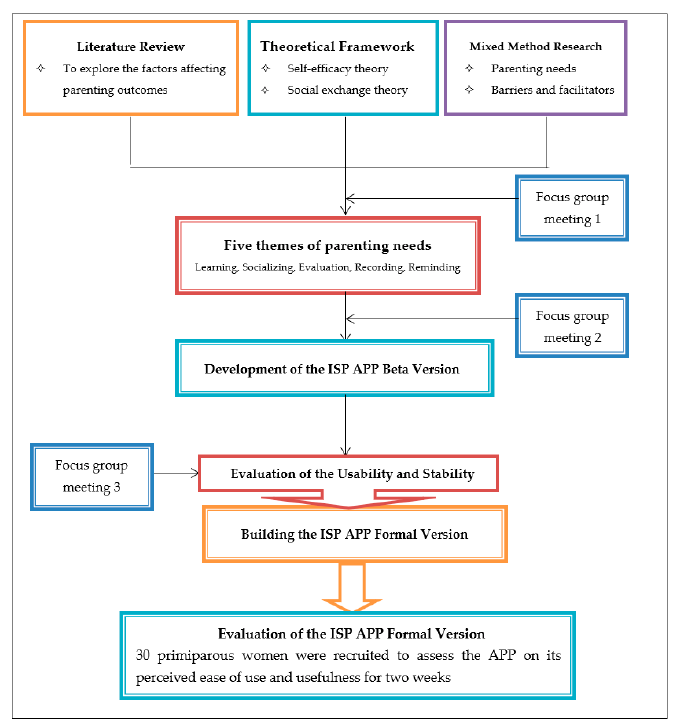
Figure 1. Stages in the process of developing the “ISP”